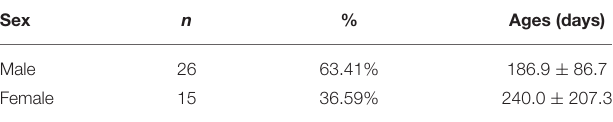
TABLE 1 | Basic indexes for children with airway